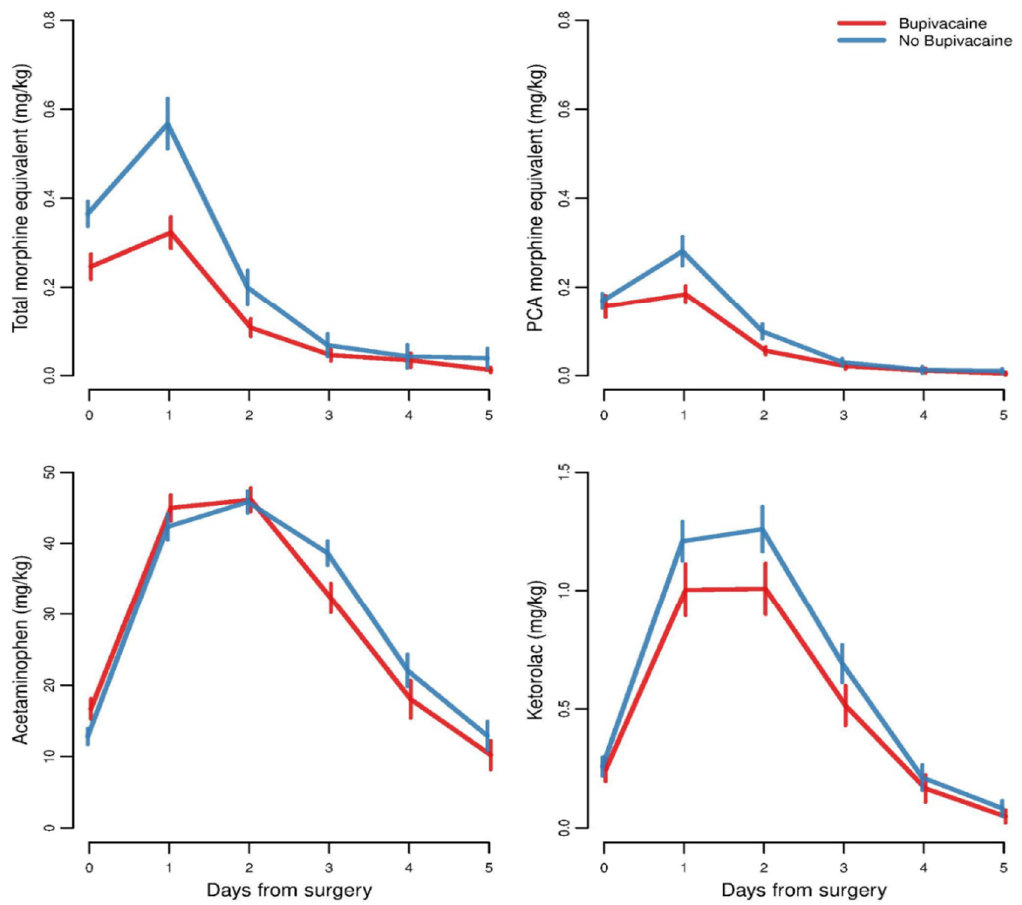
Figure 1. Change in the amount of pain medication administered for the first 5 postoperative days.